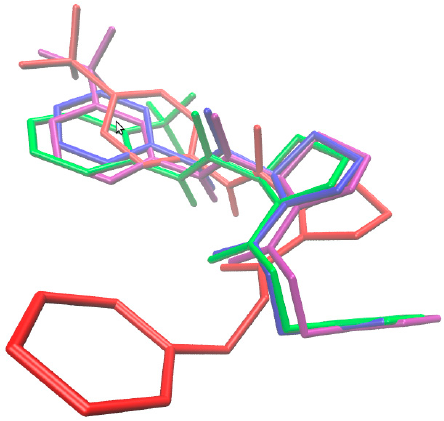
Figure 7. Comparison of poses for molecules 1 (blue), 7a (green), 7b (magenta) and 7c (red) in active site of enzyme chain A.